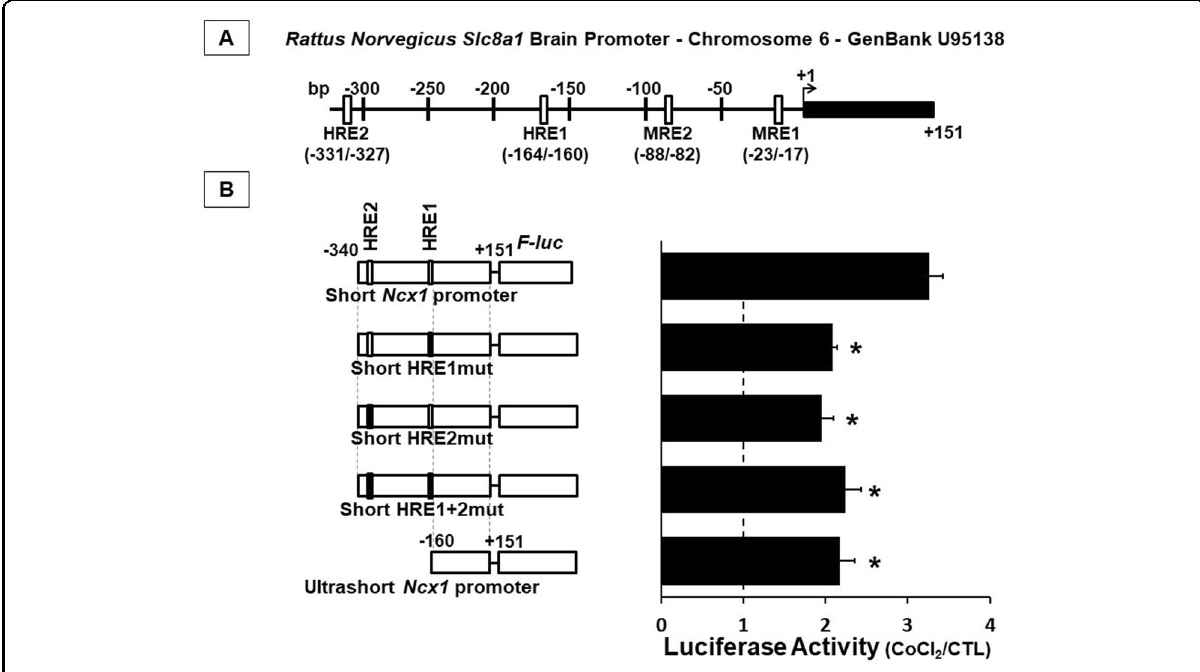
Fig. 1 HIF-1 activated the Na + /Ca 2 + exchanger brain Slc8a1 promoter. A Diagram showing the structure of the Rattus Norvegicus Na + /Ca 2 +